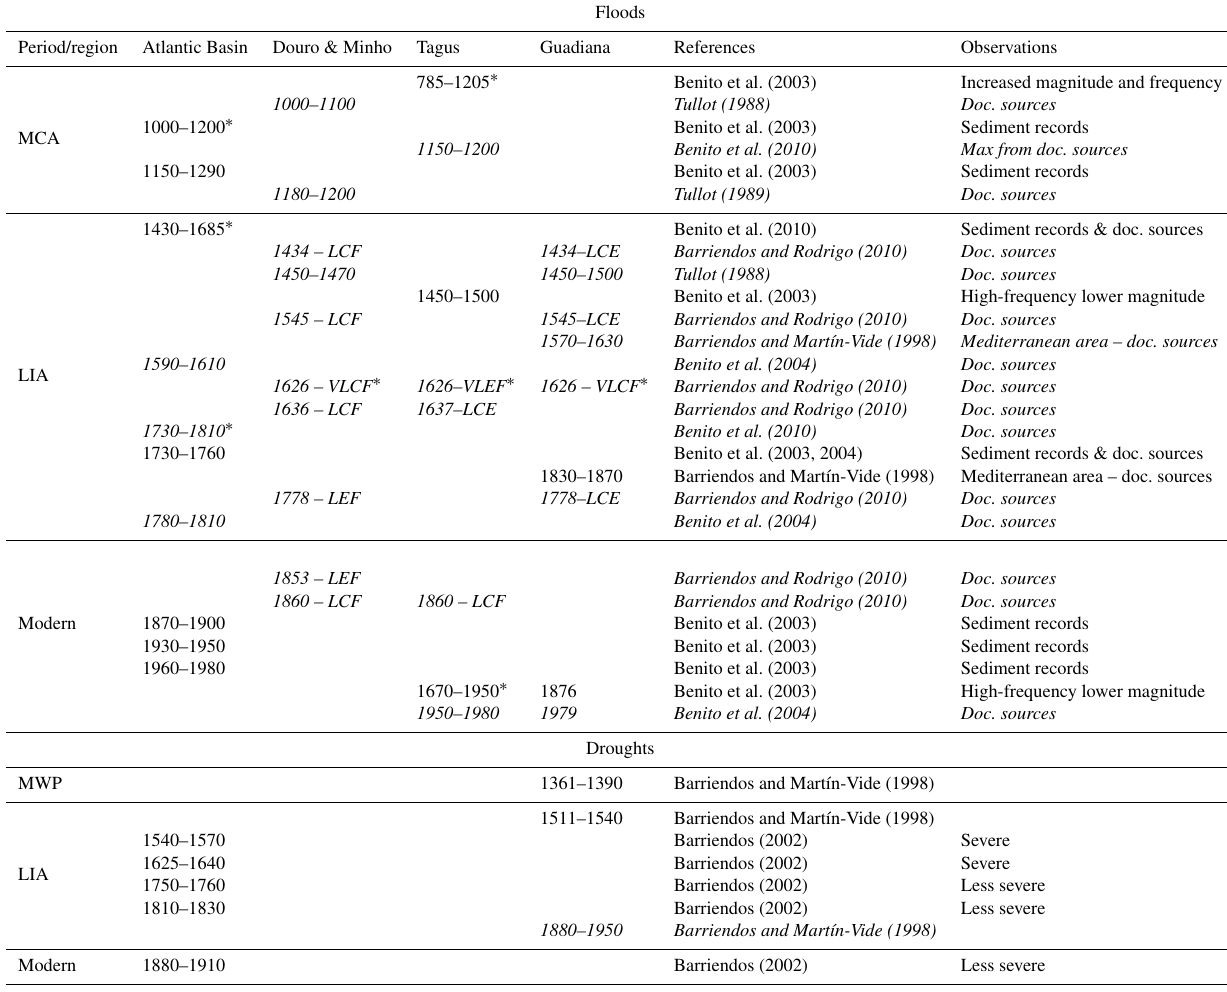
Table 3. Compilation of flooding and drought events on the western Iberian Peninsula, according to published information for the MCA, the LIA and the modern/Industrial Era. The italic font refers to the documentary